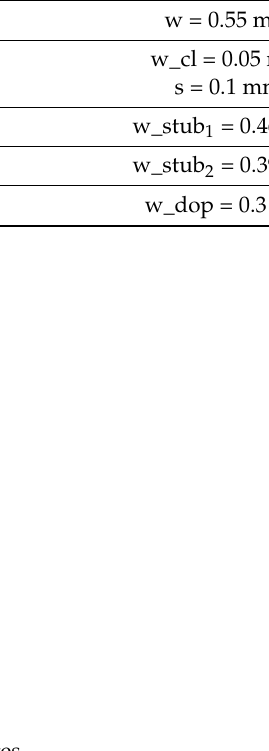
Figure 18. Measured results of the 10 GHz filter in both states. In the OFF-state, with a 0 V bias voltage, the transmission level was below − 10 dB across the whole frequency bandstop from 5.7 GHz to 17.3 GHz. In the ON-state, with a 2.3 V bias voltage, the insertion loss was 2.6 dB at the center frequency, and a return loss above 16 dB was observed. The − 3 dB bandwidth was from 5.65 GHz to 14.5 GHz. Here, with the whole measured losses of the filter and the measurement cell, the measured Qu- factor was evaluated as 7.5, with an 89% fractional bandwidth w in the ON-state. A good agreement was found between the simulated and the measured results in the OFF- and ON-states, as shown in Figure 19. ( a )